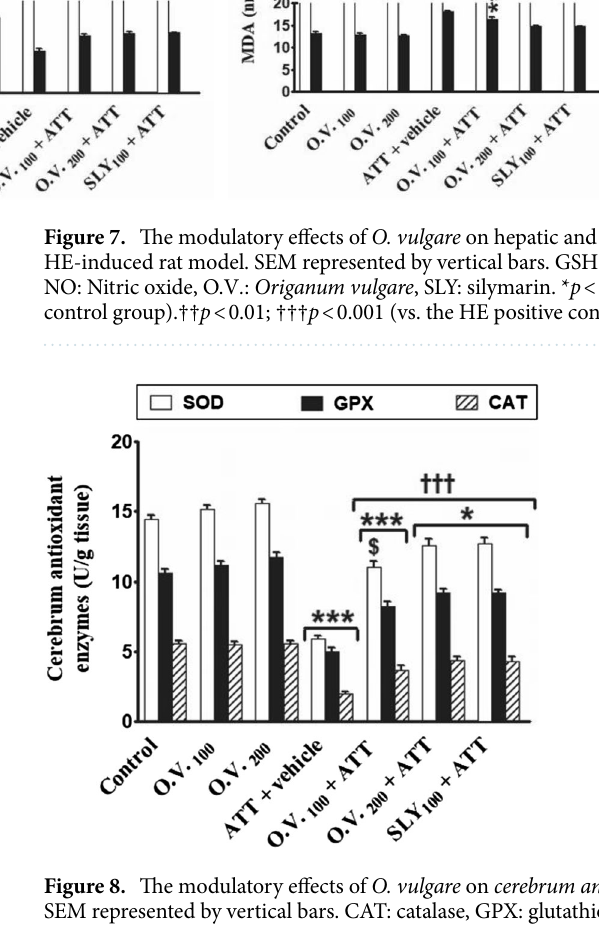
the control group (Fig. 8). On the other hand, pre-treatment with O. vulgare (100 and 200 mg/kg) or SILY signifi- cantly increased ( p < 0.001) SOD, GPX and CAT in cerebrum tissue as compared to TAA alone -treated group. The modulatory effects of O. vulgare on monoaminergic neurotransmitters level in the HE‑induced rat model. Data in Fig. 9 revealed that dopamine (DA), and norepinephrine (NE) levels in cerebrum and hippocampus were significantly decreased ( p < 0.05–0.001) in TAA alone (− 60% & − 30% for DA, and − 44% & − 48% for NE, respectively), O. vulgare 100 + TAA (− 34% & − 17% for DA, and − 29% & − 31% for NE, respectively), O. vulgare 200 + TAA (− 17% & − 9% for DA, and − 13% & − 13% for NE, respectively) and SILY + TAA-treated groups (− 18% & − 9% for DA, and − 13% & − 14% for NE, respectively), while serotonin (SE), and AchE level in cerebrum and hippocampus were significantly increased ( p < 0.05–0.001) in TAA alone (86% & 42% for SE and 137% & 70% for AchE, respectively), O. vulgare 100 + TAA (56% & 29% for SE and 28% & 29% for AchE, respectively), O. vulgare 200 + TAA (25% & 20% for SE and 20% & 14% for AchE, respectively) and SILY + TAA-treated groups (24% & 20% for SE and 19% & 14% for AchE, respectively) compared with the control group. Further, pre-treatment with O. vulgare (100 and 200 mg/kg) or SILY significantly attenuated ( p < 0.001–0.001) the changes in serotonin, dopamine, norepinephrine, and AchE levels in cerebrum and hip- pocampus compared to TAA alone-treated group.